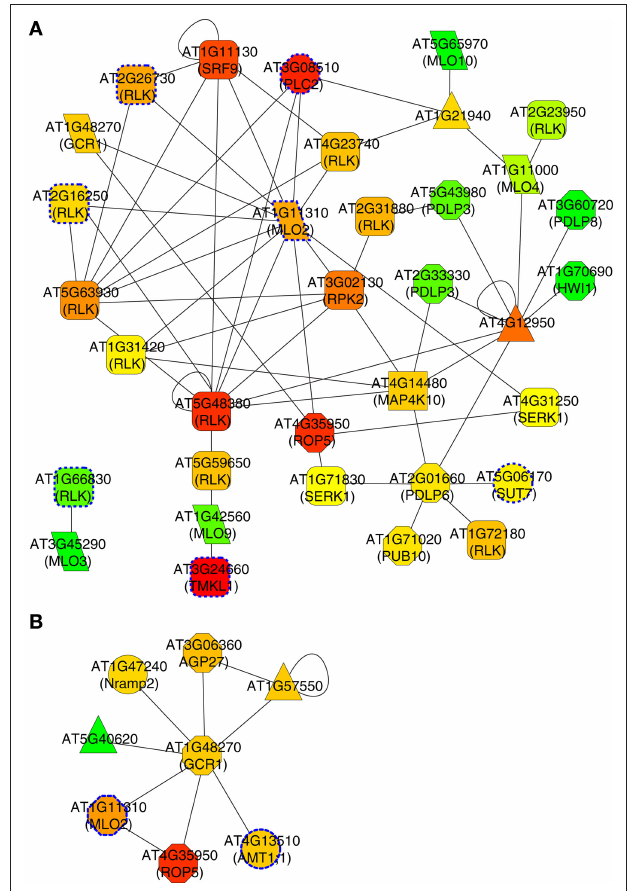
Figure 6 | Sub-network of 7TM receptors. (A) Members of the MLO receptor family are displayed as a sub-network. (B) GCR1 sub-network (AT1G48270). Labeling as in Figure 5